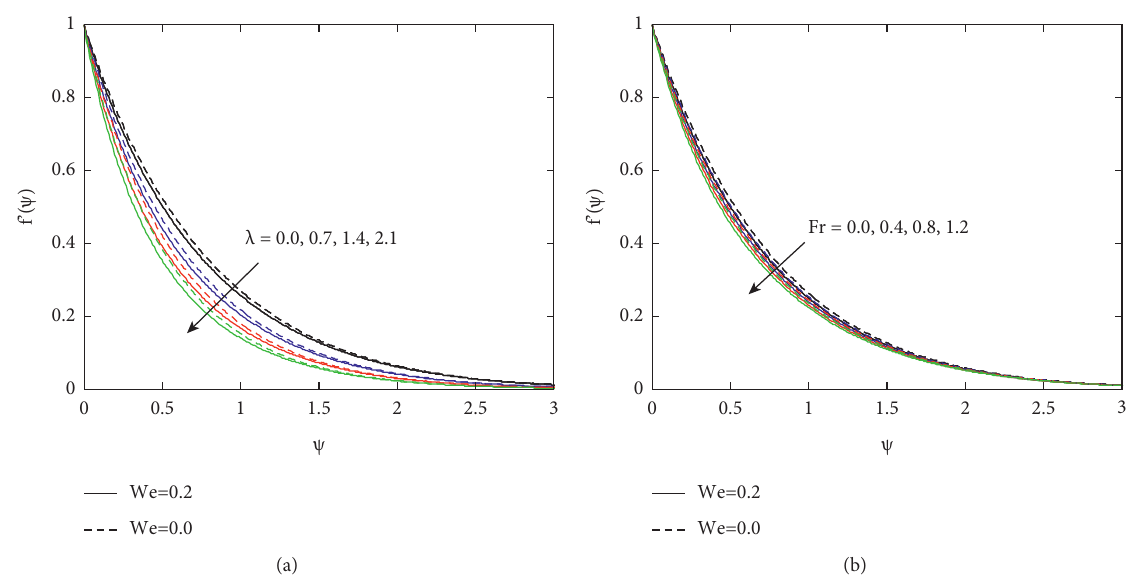
Figure 2: The velocity distribution for diverse quantity of λ (a) and Fr